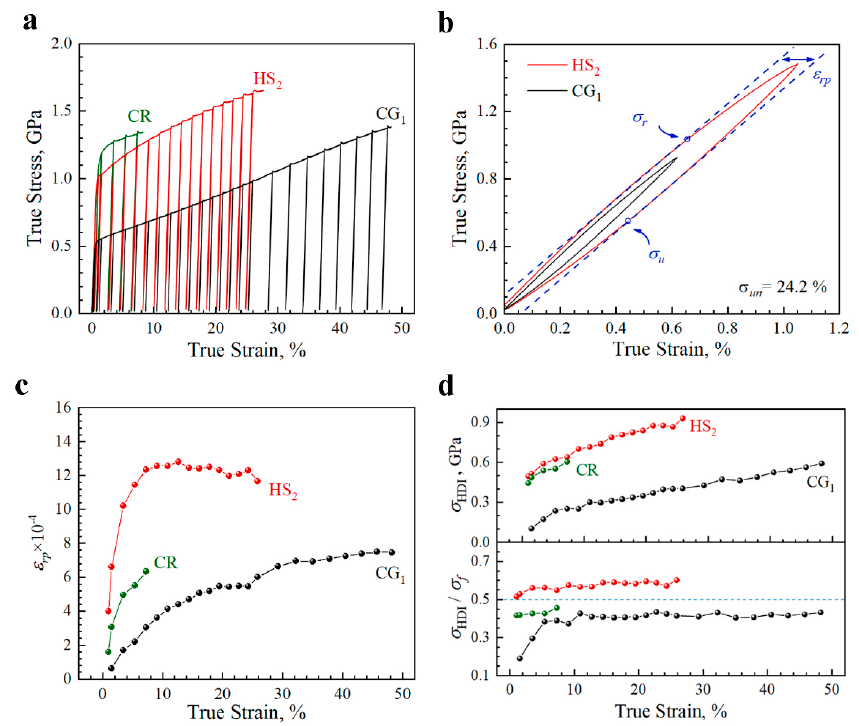
Figure 5. HDI hardening for the typical samples. ( a ) True stress–strain curves for LUR tests. ( b ) Typical hysteresis loops. ( c ) 𝜀 rp as a function of true strain. ( d ) σ HDI / σ f and σ HDI as a function of hysteresis loops. ( c ) ε rp as a function of true strain. ( d ) σ HDI / σ f and σ HDI as a function of true true strain.